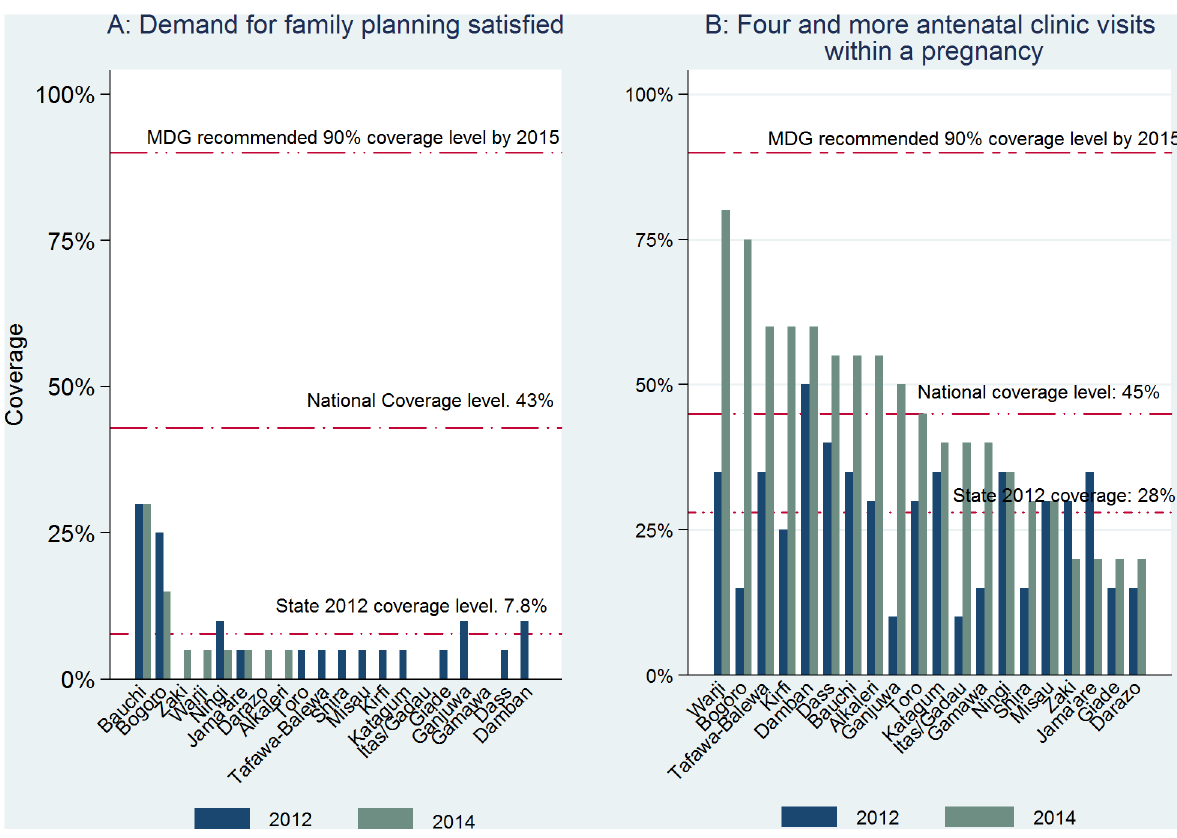
Fig 2. Pre-pregnancy and Pregnancy continuum: coverage levels of demand for family planning satisfied and at least four antenatal clinic visits during a pregnancy by LGA. 2012 and